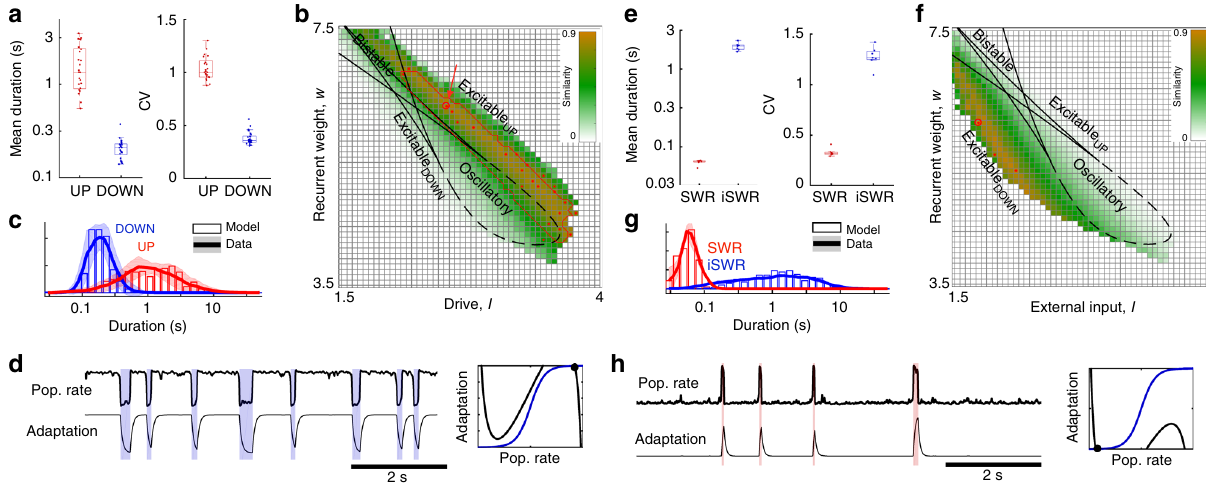
Fig. 4 Neocortex and hippocampus are in excitable regimes during NREM sleep. a Mean and CV of UP/DOWN state durations, each point is a single recording session. b Similarity between simulated and experimental duration distributions (see Supplementary Fig. 6, Methods for similarity calculation). Color indicates mean similarity over all recordings, red line outlines region for which model simulations fall within mean ± 2STD of experimentally observed CV UP , CV DOWN and mean UP /mean DOWN ratio. 25 red dots indicate the most similar parameters for each of the 25 recordings, and large circle (arrow) is best mean similarity. c Neocortical duration distributions for data and model simulation in the best mean similarity parameters indicated in b . ( I = 2.64, W = 6.28, b = 1). d Simulated r-a model with the best-matching parameters. (Right) Phase plane diagram for model with best- fi t parameters, in the Excitable UP regime. e Mean and CV of SWR/interSWR state durations, each point is a single recording session ( n = 7 hippocampal sessions). f Similarity between simulated and experimental duration distributions as in b . g Hippocampal duration distributions for data and model simulation in the best mean similarity parameters. h Simulated r – a model with the best-matching parameters indicated in f . ( I = 1.9, W = 6, b = 1). (Right) Phase plane diagram for model with best- fi t parameters, in the Excitable DOWN regime. Box plots center line: median, box limits: upper/lower quartiles, whiskers: data range (excluding outliers). Shaded lines re fl ect mean ± standard deviation over recordings